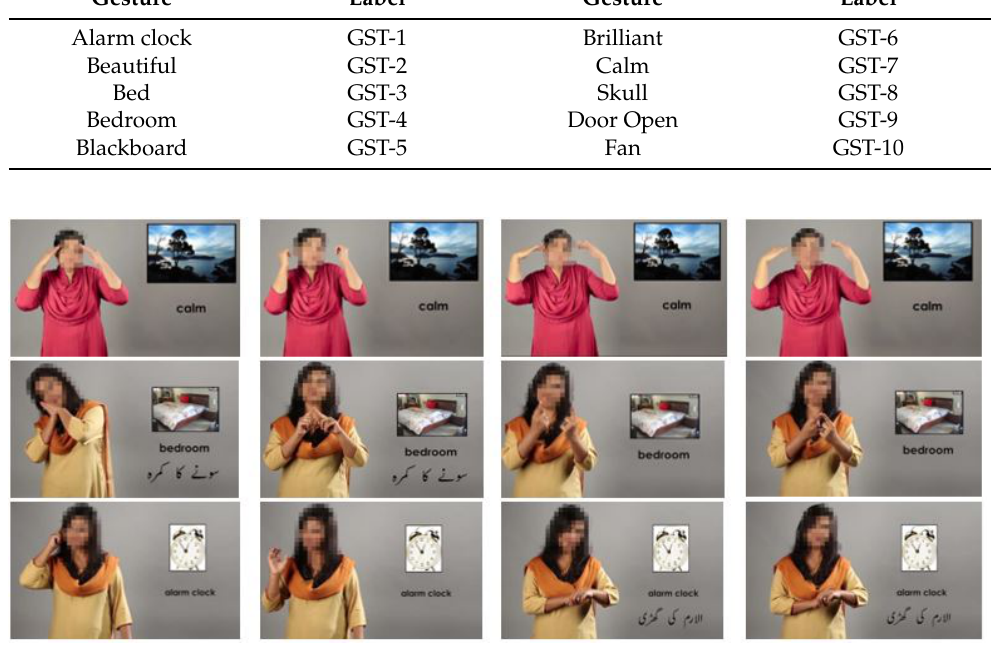
Figure 3. Pictorial overview of different gestures